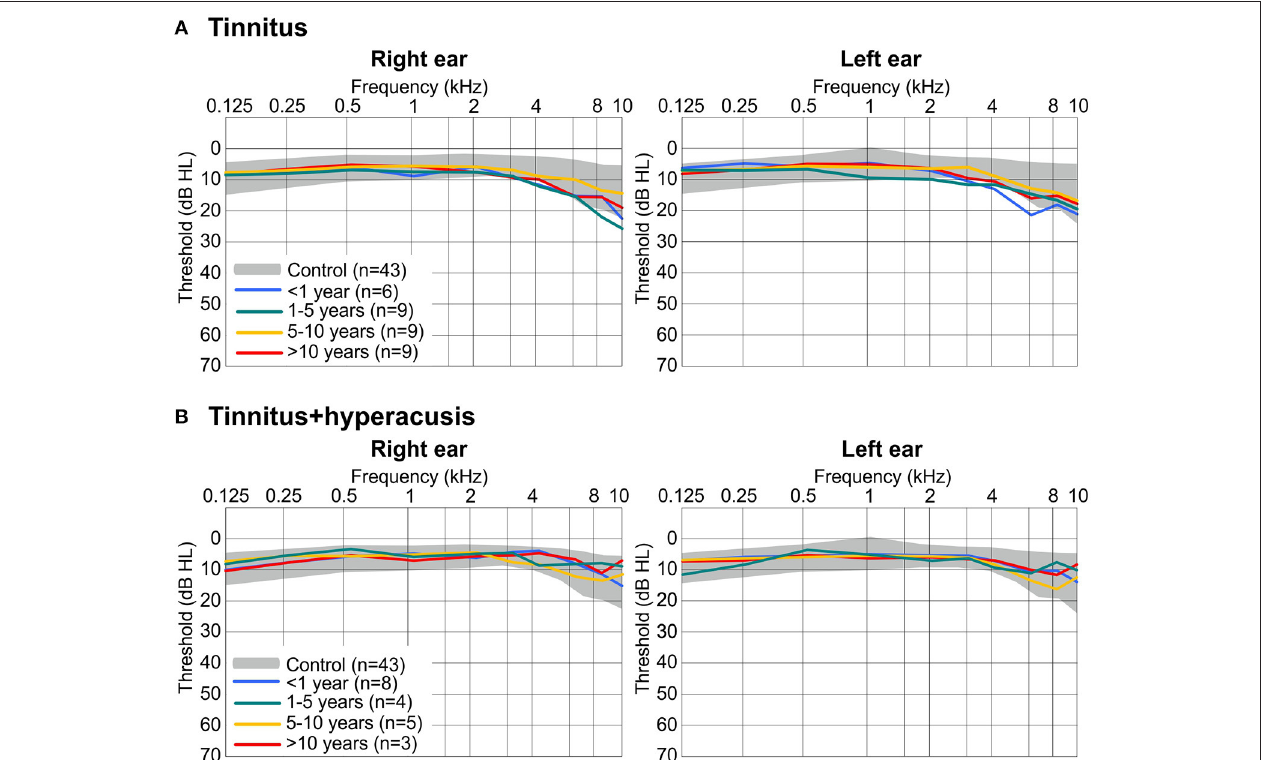
FIGURE 2 | Hearing sensitivity for right ear (left) and left ear (right) determined by pure tone audiometry (threshold in dB hearing level, HL). (A) Thresholds range from 43 controls (gray shaded areas display the normal range of ± one standard deviation) and mean of 33 participants with tinnitus only, split into 4 groups according to the duration of tinnitus. (B) Mean thresholds from 20 participants with tinnitus + hyperacusis, split into 4 groups according to the duration of their tinnitus. The same values for controls are displayed in (A,B) . Hearing thresholds did not statistically significant differ in ears or in participant groups using Kruskal-Wallis test with P >